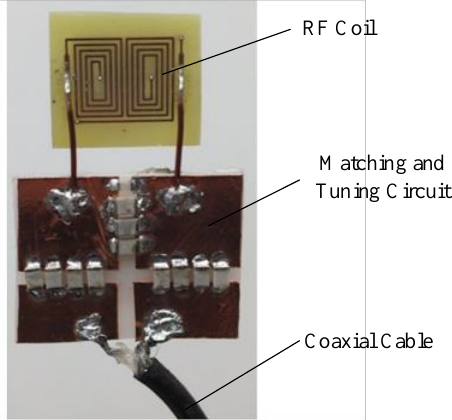
Figure 6. The RF coil and its matching and tuning circuit.